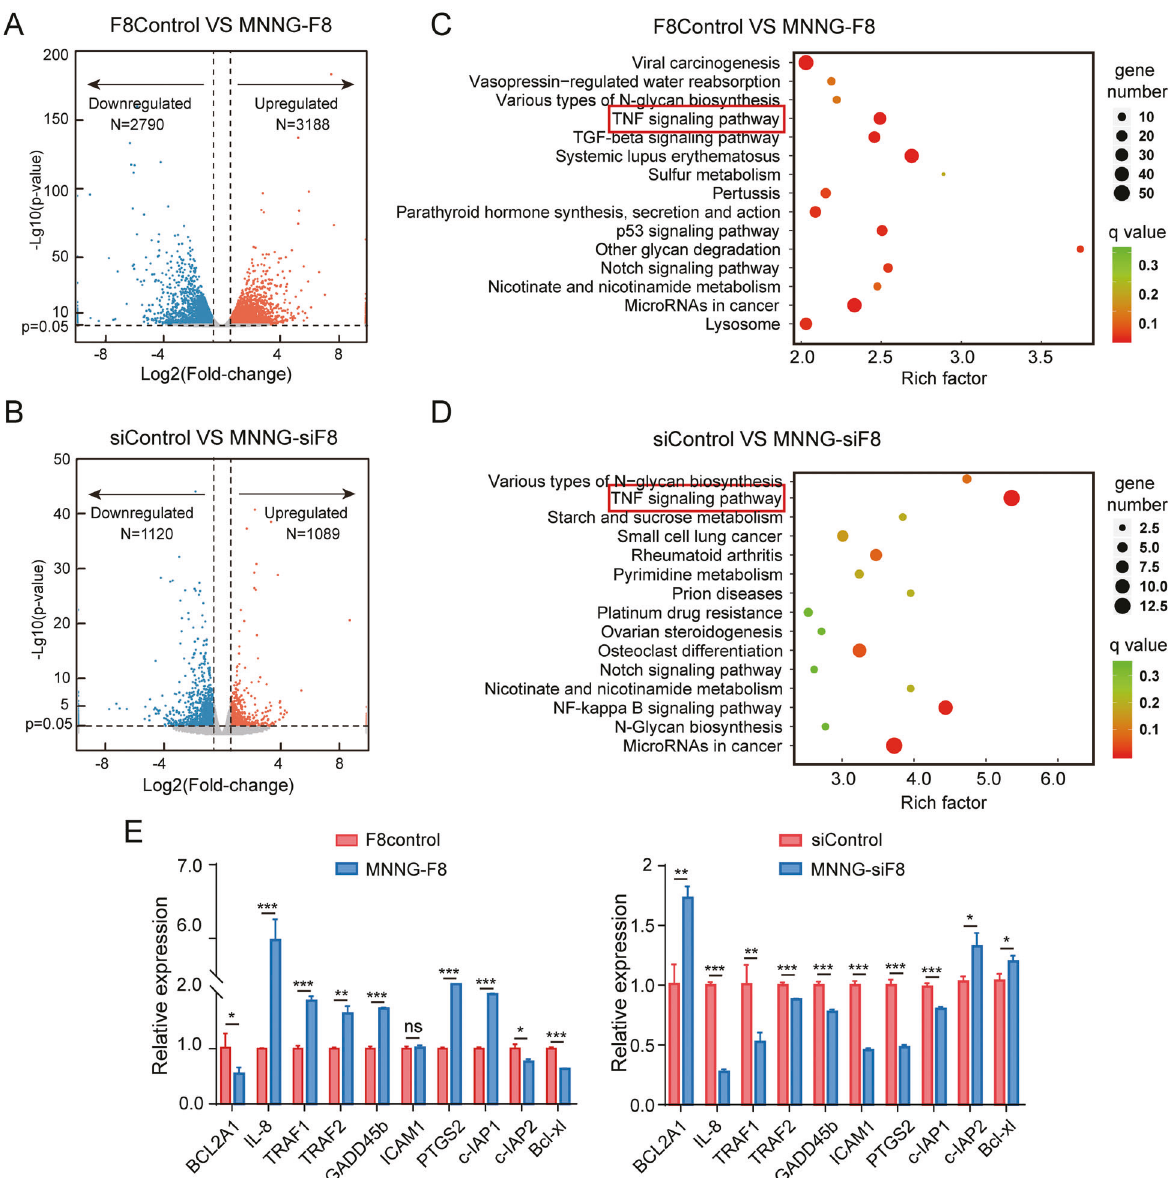
values on the abscissa were log2-transformed, and P values on the ordinate were -log10 transformed. The selection criteria of differential expressed genes (DEG) was P -value < 0.05 and changed expression higher than 1.5 or lower than 0.67 fold. C , D KEGG pathway enrichment analysis for DEGs between the two FUT8-regulated cells and their controls. E Mean ± SD ( N = 3) relative expression of DEGs. Among the DEGs, genes that are highly related to the TNF/NF- κ B2 pathway were veri fi ed by RT-qPCR to be expressed in the FUT8-altered cells and their controls. ns På 0.05; * P < 0.05; ** P < 0.01; *** P <